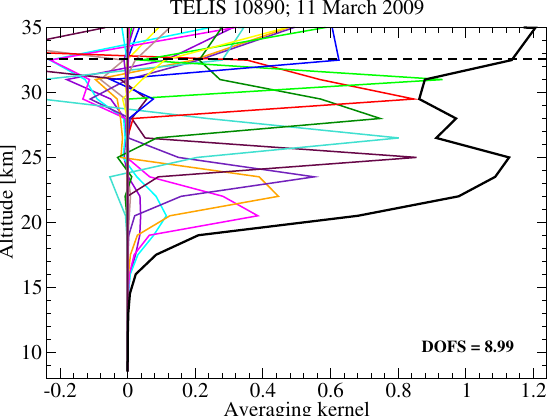
Figure 18. Averaging kernels and DOFS for the OH retrieval from TELIS FIR measurement 10890 (11 March